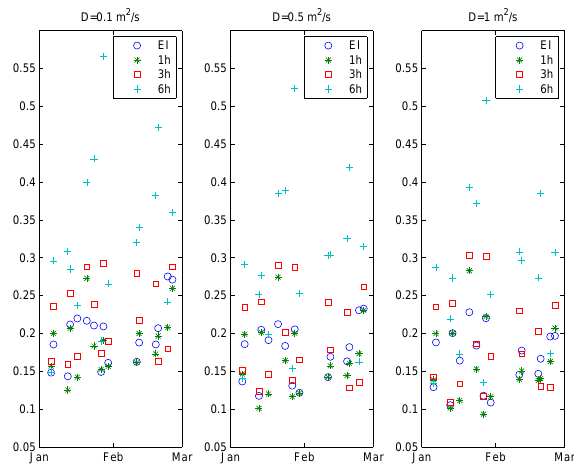
Fig. 5. Integrated absolute value (i.e. norm L 1 ) of the difference between the SHADOZ mea- sured profiles and the reconstructions performed with meteorological winds with temporal reso- lutions of 6 hours(6h, cyancrosses),3 hours(3h, red squares)and 1hour (1h, green stars)and with ERA Interim at 3 hours resolution (EI, blue circles). The units of the vertical axis are ppmv of O 3 per measurement point. Every point corresponds to the average of the reconstructed profiles (with back trajectories between 96 and 504 hours) for the matches with the available REPROBUS output fields.